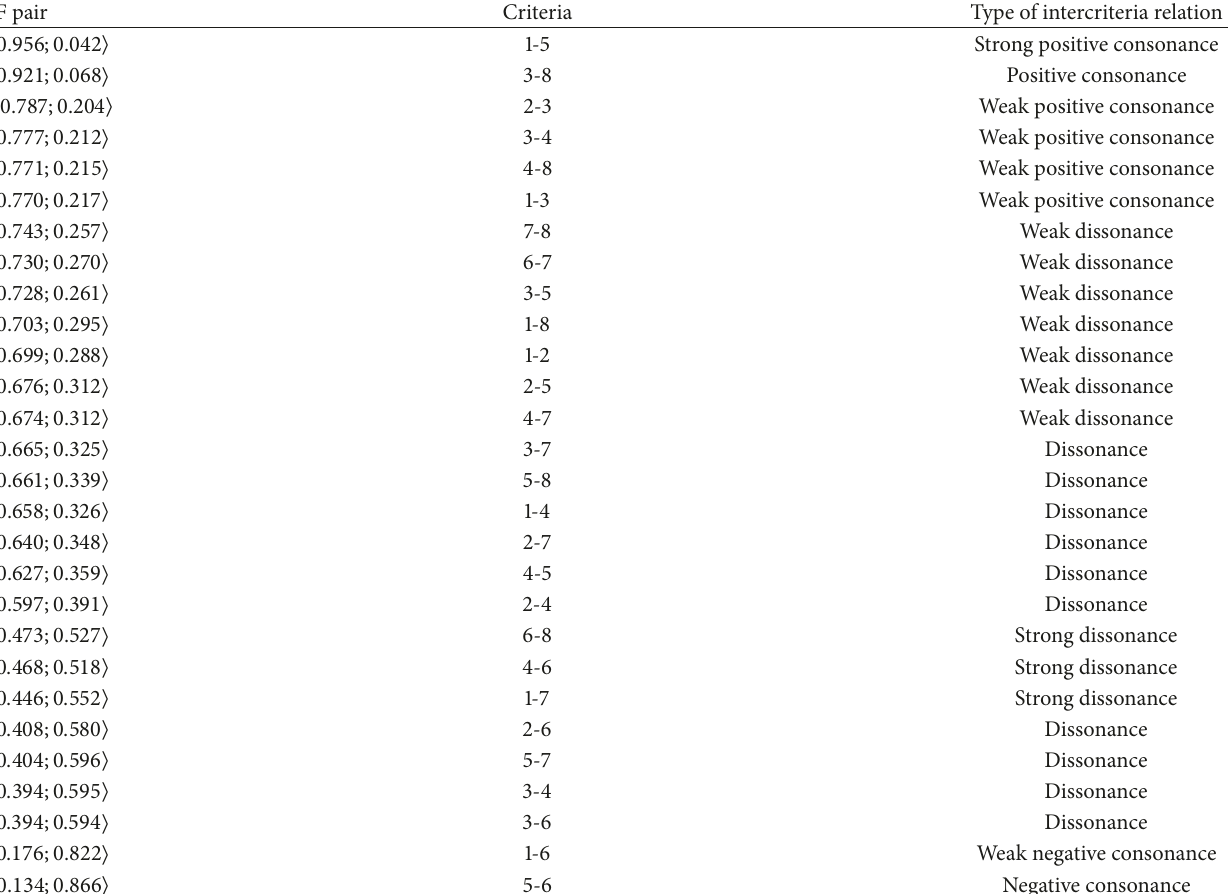
Table 3: Relations among the criteria with specific